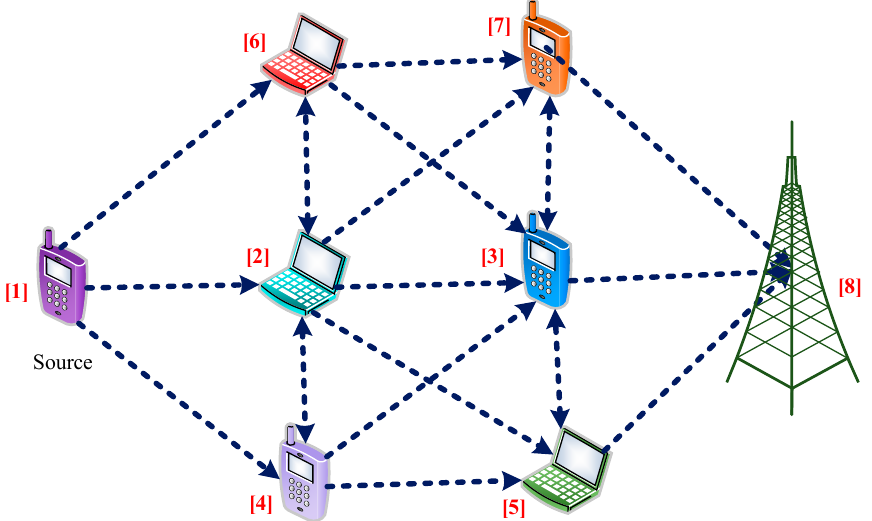
Figure 2. Multiple routes between source and destination devices in a D2D communication scenario.